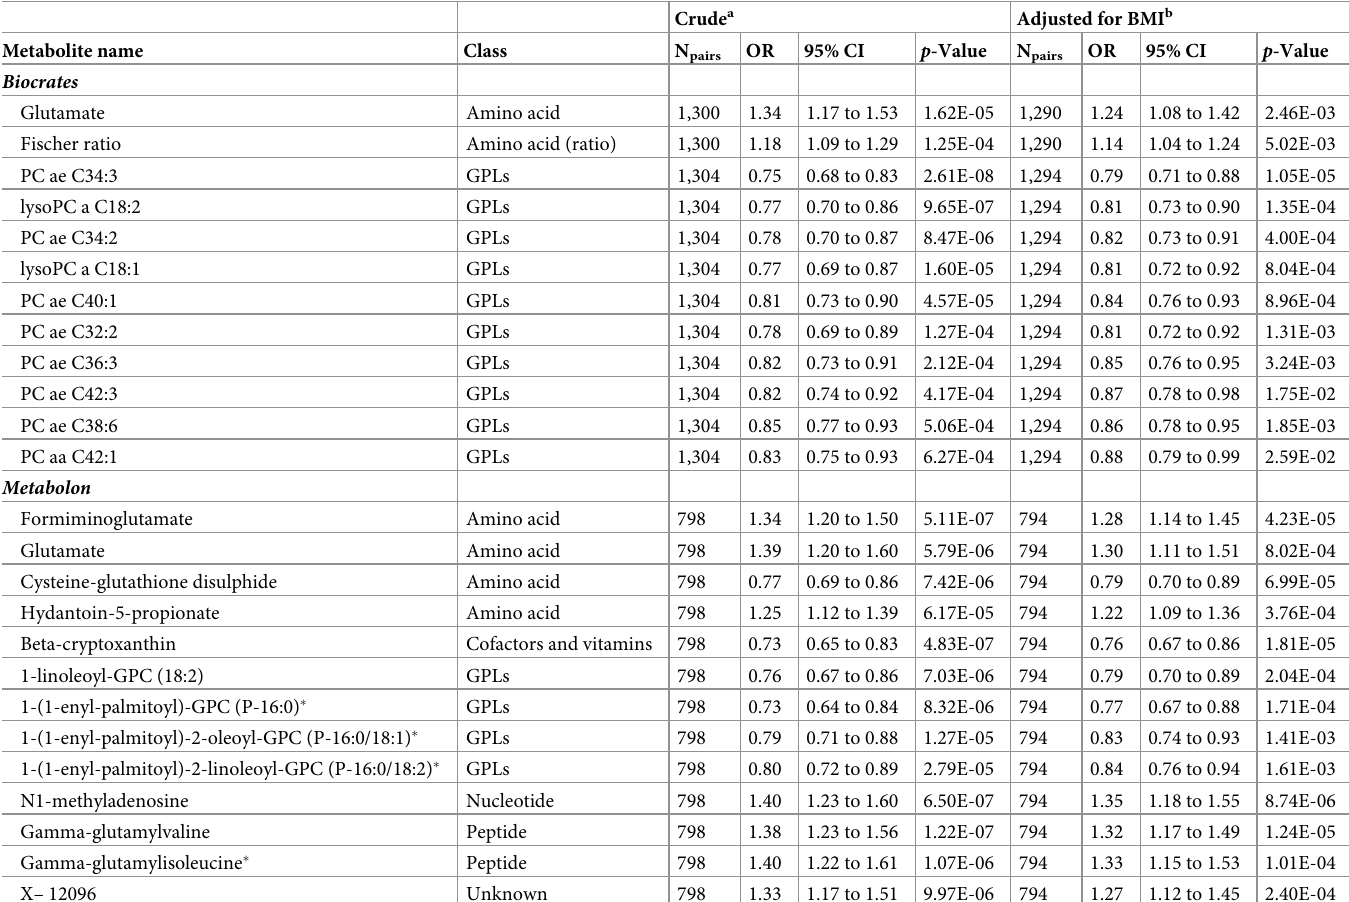
Table 2. Metabolites robustly C associated with kidney cancer